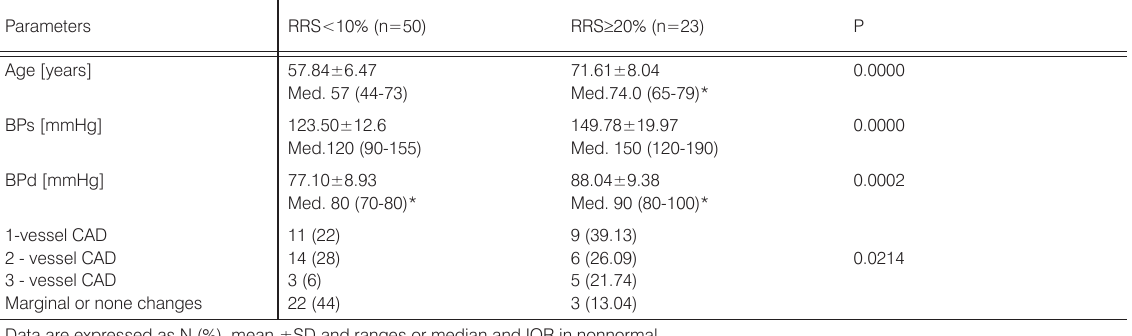
Table 4. Significant differences between patients with low vs high Reynolds Risk Score